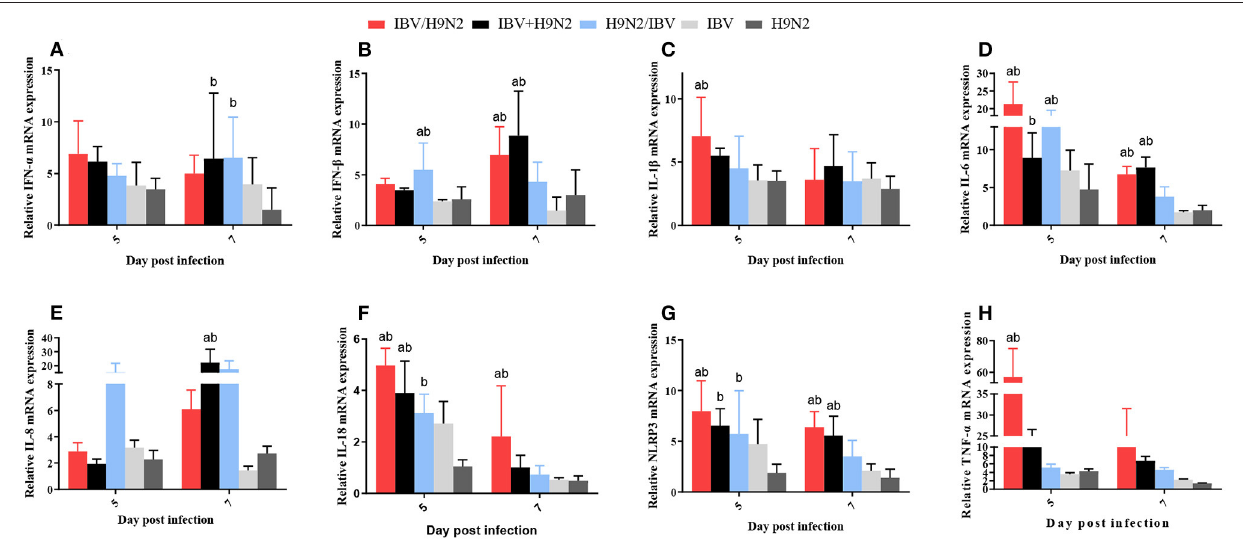
FIGURE 11 | Effect of co-infection with IBV and H9N2 virus on inflammatory cytokines in the kidneys. (A) IFN- α , (B) IFN- β , (C) IL-1 β , (D) IL-6, (E) IL-8, (F) IL-18, (G) NLRP3, and (H) TNF- α . Data are presented as means ± SD. “a” indicates a significant difference ( P < 0.05) between the three co-infection groups and the IBV group. “b” indicates a significant difference (P < 0.05) between the three co-infection groups and the H9N2 group. “ab” indicates a significant difference ( P < 0.05) between the three co-infection groups and the H9N2 group. IBV, infectious bronchitis virus; IFN, interferon; IL, interleukin; NLRP3, NLR family pyrin domain containing 3; TNF- α , tumor necrosis factor- α ; SD, standard